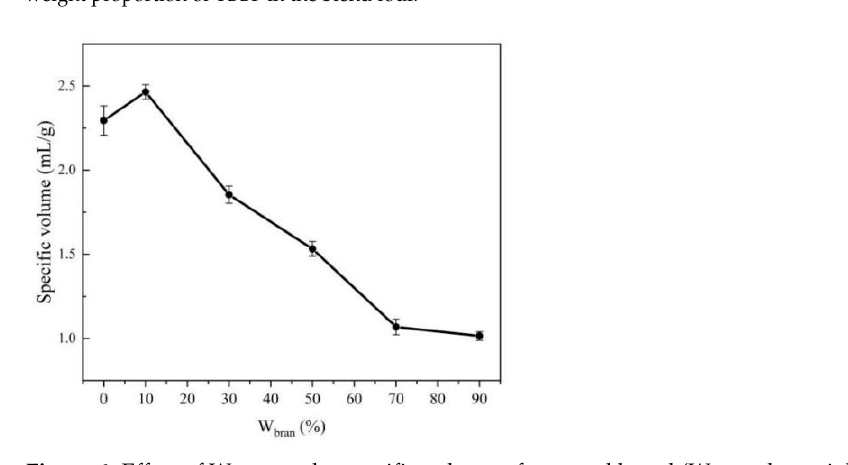
Figure 6. Effect of W bran on the specific volume of steamed bread (W bran : the weight proportion of TBBF in the blend four). Table 7. Effect of W bran on parameters values of Mixolab curves of mixed